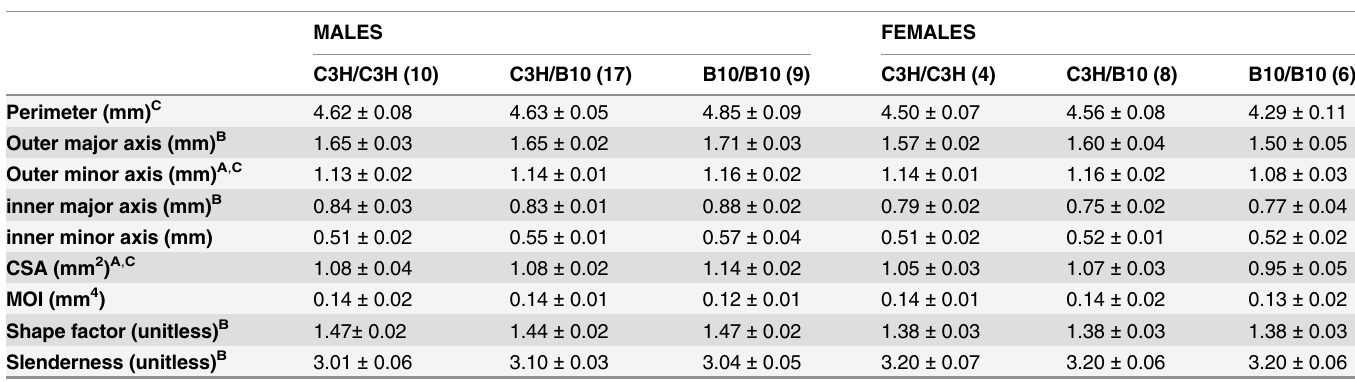
Table 5. Femoral Geometry of C.B.4.2